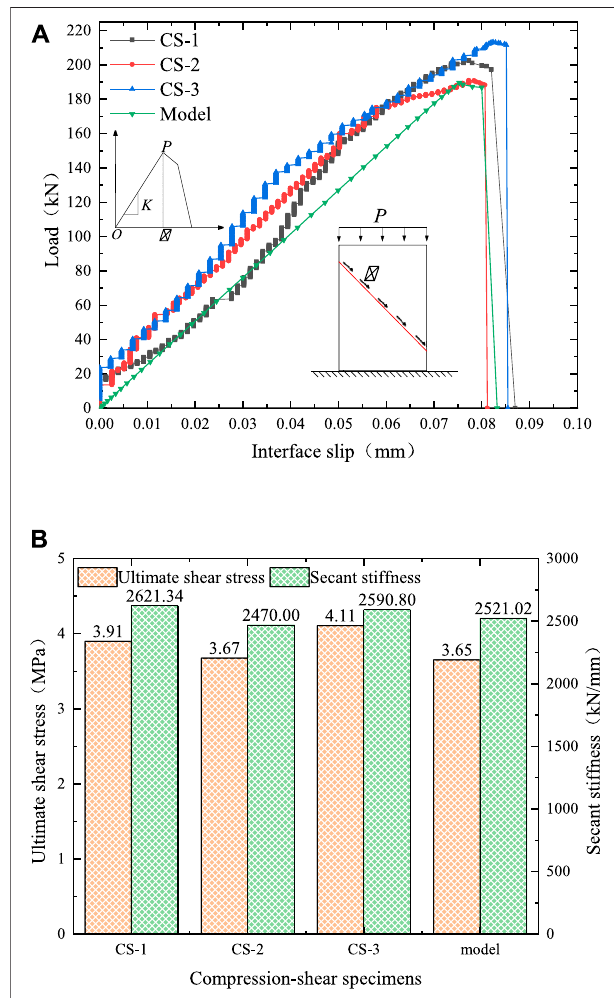
FIGURE 4 | Comparison of compression-shear test and model results. (A) Load – slip curve. (B) Characteristic